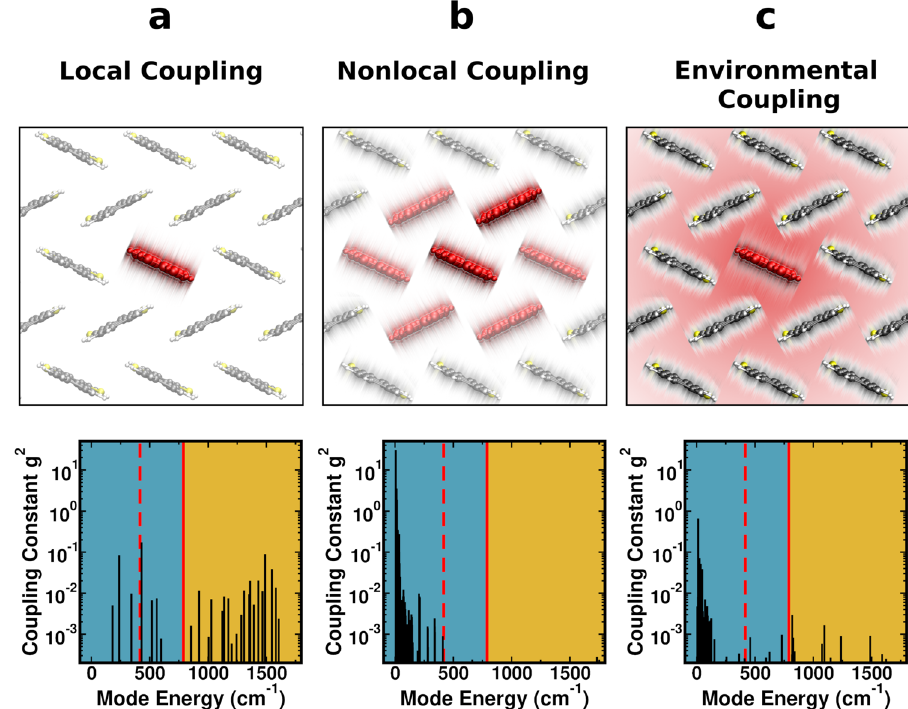
Fig. 2 Mode-resolved EPC. Top: three types of EPC implemented in this approach: a local coupling to the onsite energies, b nonlocal coupling to the transfer integrals between two molecules and c environmental coupling to the electrostatic crystal fi eld. Bottom: mode-resolved squared EPC constant g 2 for the three types of coupling of the exemplary molecule DNTT. The energy scale of transport ε max vertical bar. The modes that are treated quasi-statically are highlighted in blue, while the ones that are treated with the polaron approach are highlighted in orange. Twice the thermal energy 2 k B T at room temperature, which is the separating energy for small transfer integrals, is highlighted as dashed red